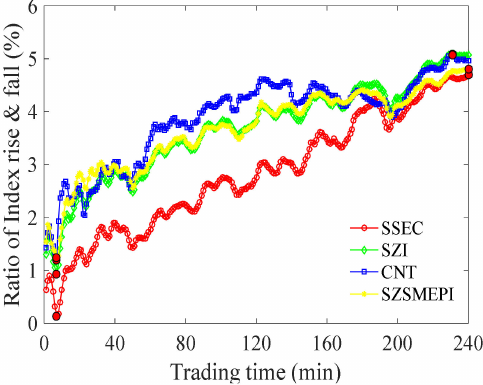
Figure 3. Movement of stock market indices on 1 June